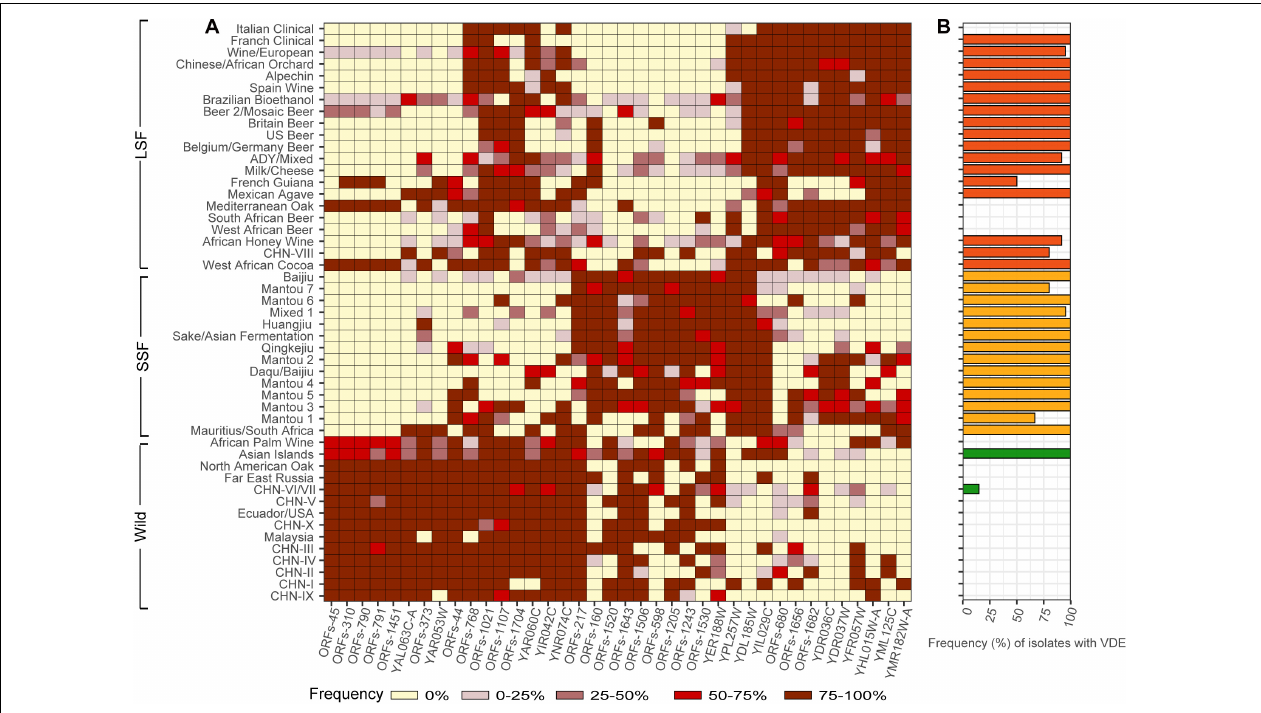
FIGURE 4 | Distribution of selected genes in different populations, groups and lineages of S. cerevisiae . (A) Frequencies of isolates in different lineages harboring the genes listed at the bottom. These genes are shared by the majority ( > 90%) of the isolates in one group but occur in limited isolates ( < 10%) in another group. Frequency ranges are depicted using different colors as shown at the bottom. (B) Frequencies of isolates harboring the homing endonuclease VDE in gene VMA1 in different lineages in the wild (dark green), liquid- (red) and solid-state fermentation (orange)